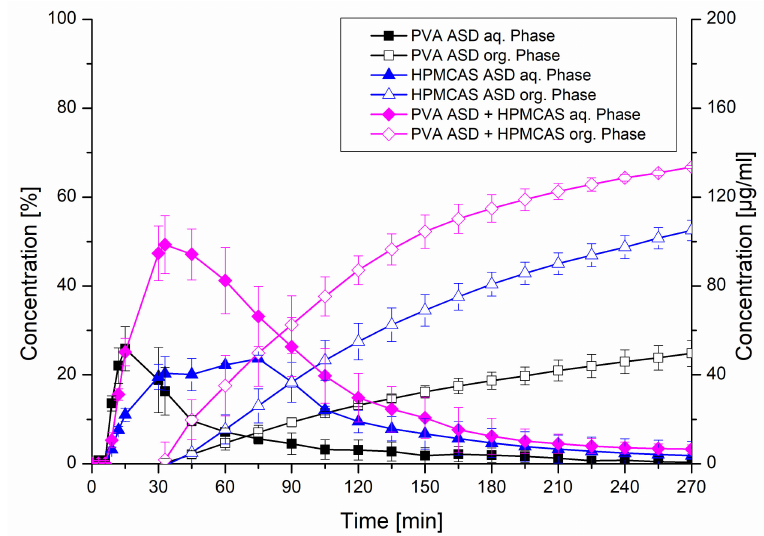
Figure 9. Biphasic dissolution studies of plain ASDs and the PVA ASD with admixed HPMCAS powder at a drug load of 20%. The aqueous medium consisted of FaSSIF adjusted to pH 6.8 and the organic phase was